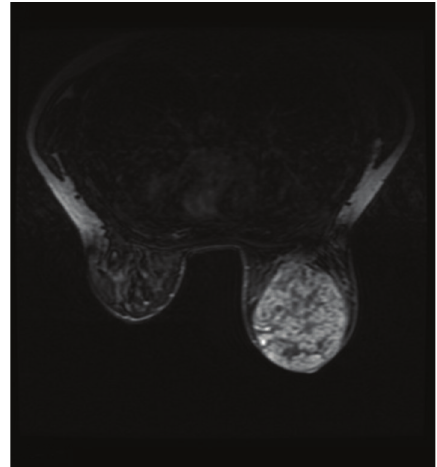
Figure 2: MRI showing the 10 cm well-circumscribed rounded mass lesion which demonstrated a benign enhancement pattern after intravenous Gadolinium.